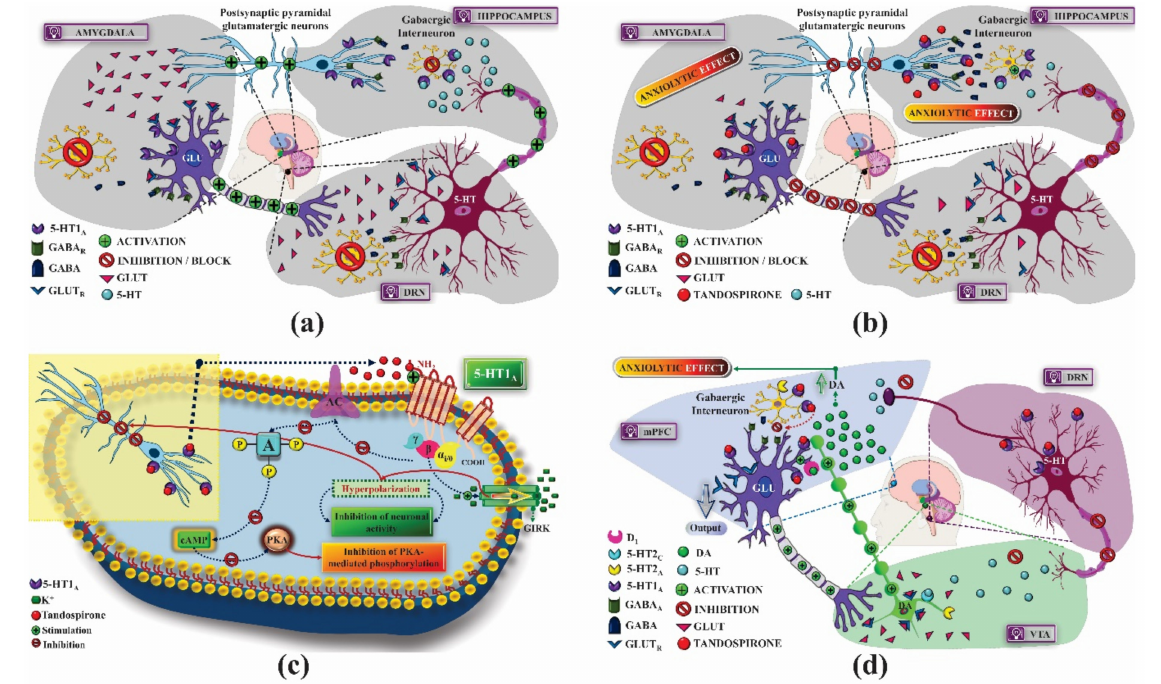
Figure 3. Anxiolytic mechanism of tandospirone. 5-HT 1A : ( a ) Biological factors have been implicated in the pathogenesis of anxiety. Neurochemical evidence suggests that the dysregulation of serotonin, norepinephrine, gamma-aminobutyric acid (GABA), glutamate, and peptides (corticotropin releasing factor, cholecystokinin, neuropeptide Y) transmission systems are strongly correlated with the pathophysiology of anxiety. In the classic concept of stress, homeostasis is threatened by physical and psychological events, known as stressors. Behavior is aimed at assessing the destabilizing potential of the stressor. If the stressor event does not correspond to any cognitive representation based on previous subjective experiences, there is an increase in alertness, hypervigilance, focused attention, and cognitive processing. The interface between sensory information received and the evaluation process is formed in the limbic region of the brain, which comprises structures such as the hippocampus, the amygdala, and the medial prefrontal cortex (mPFC). The components of the human fear circuit, which can be of particular relevance for destabilization produced by the stressor and, consequently, induction of anxiety, include mPFC (subservient fear extinction processes), the amygdala (risk assessment processing), and the hippocampus. The ascending serotonergic pathway that projects from the DRN into the hippocampus may be implicated in the genesis of behavioral inhibition observed in dangerous situations. During episodes of anxiety crisis, it is postulated that these serotonergic inputs in the hippocampus activate 5-HT 1A receptors in GABAergic interneurons. In this case, 5-HT 1A receptors coupled to the G α i/0 protein block adenylate cyclase (AC), prevent the formation of cyclic adenosine monophosphate (cAMP) and reduce the activation of protein kinase A (PKA) which, once reduced, decrease the permeability of calcium (Ca 2+ ) to specific channels located in the cell membrane. This reduction in the calcium influx into the GABAergic interneuron culminates in the blocking the exocytosis of the GABA neurotransmitter. The reduction of the hippocampal GABAergic transmission causes an increase in the number of post-synaptic pyramidal glutamatergic neurons fires, stimulating anxiety-related regions such as the amygdala and the DRN, which feeds back and over-stimulates the anxiety-related circuit; ( b , c ); tandospirone has a promising anxiolytic effect, which has been shown in animal models, especially of the generalized anxiety disorder (GAD). Tandospirone acts as an anxiolytic by activating the post-synaptic 5-HT 1A receptor coupled to the G α i/0protein, resulting in reduced cAMP formation and PKA inhibition. On the other hand, it activates the G protein-controlled internal rectifying potassium channels (GIRK) by releasing G βγ subunits, leading to intracellular potassium (K + ) efflux, hyperpolarization of target neurons and, finally, inhibition of the local neuronal activity [24]; ( d ) another mechanism by which tandospirone exerts its anxiolytic effect is by increasing the release of dopamine (DA) in the VTA. In this case, tandospirone activates the 5-HT 1A receptor in DRN or mPFC, directly or indirectly, stimulating dopaminergic transmission in VTA